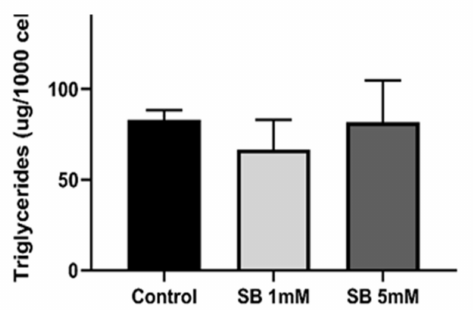
Figure 3. In contrast to its influence on cholesterol, butyrate has no influence on the triglyceride content of HepG2 cells. HepG2 cells were treated for 24 h with 1 mM or 5 mM sodium butyrate (SB) and cell triglyceride measured using the High Sensitivity Triglyceride Fluorometric Assay Kit (Sigma-Aldrich). Results represent the mean combined from at least three independent experiments, with error bars representing